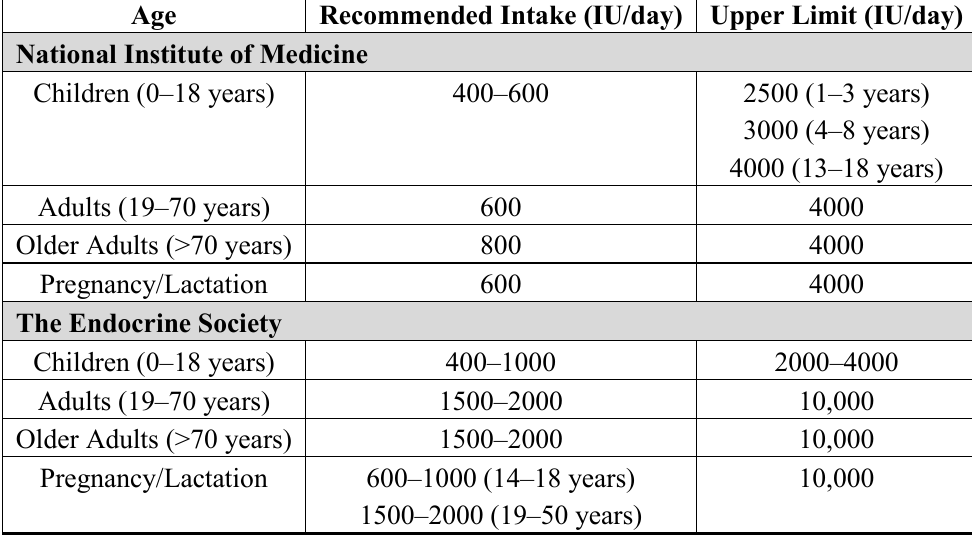
Table 1. Recommended vitamin D intake levels of the Institute of Medicine vs. Endocrine Society